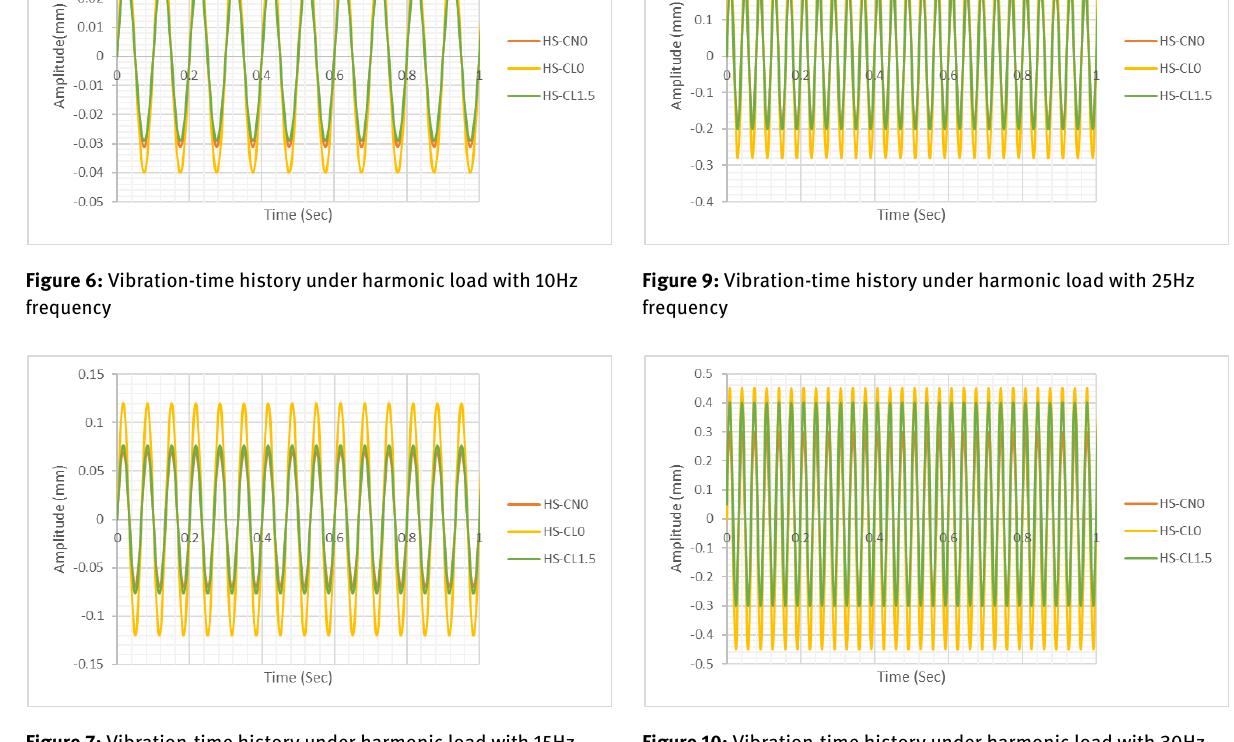
Figure 7: Vibration-time history under harmonic load with 15Hz frequency